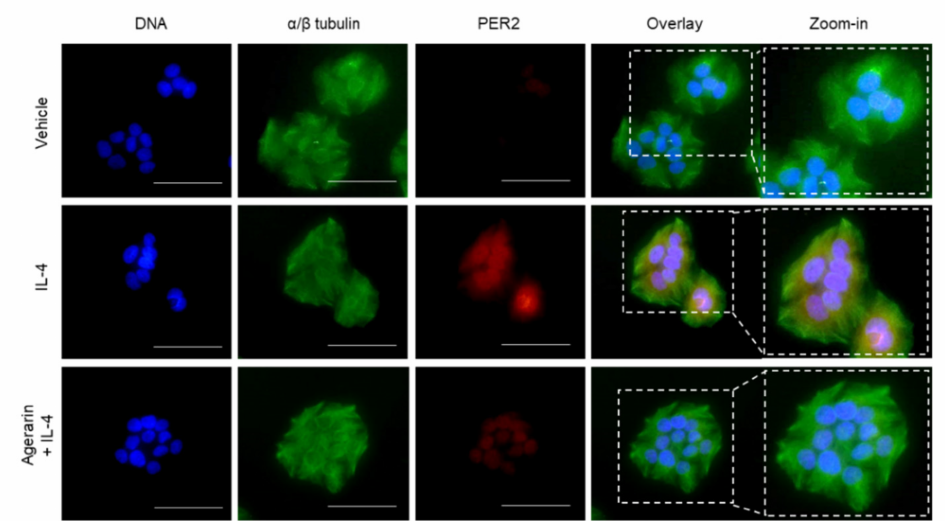
Figure 5. Effect of agerarin on IL-4-induced localization of PER2. HaCaT cells cultured on coverslips were treated with vehicle (PBS), 20 ng/mL IL-4, or 20 ng/mL IL-4 plus 40 µ M agerarin for 24 h, followed by fixing and permeabilization. Immunofluorescence staining was performed using anti- PER2 and Alexa Fluor 555-conjugated secondary antibodies (red staining). The α / β -tubulin was counterstained with anti- α / β -tubulin and Alexa Fluor 488-conjugated secondary antibodies (green staining). Nuclear DNA was stained with 1 µ g/mL Hoechst 33258 (blue staining). Fluorescent cells were captured with an EVOSf1 fluorescence microscope. The last panel on the right is a zoomed-in view of the dotted box. Scale bars, 50 µ m.